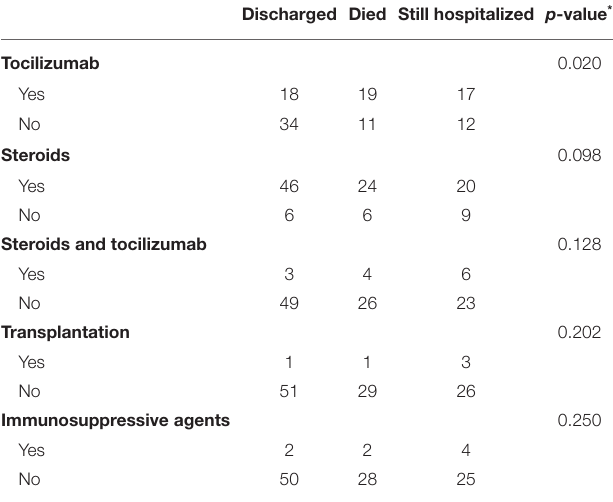
TABLE 2 | Clinical